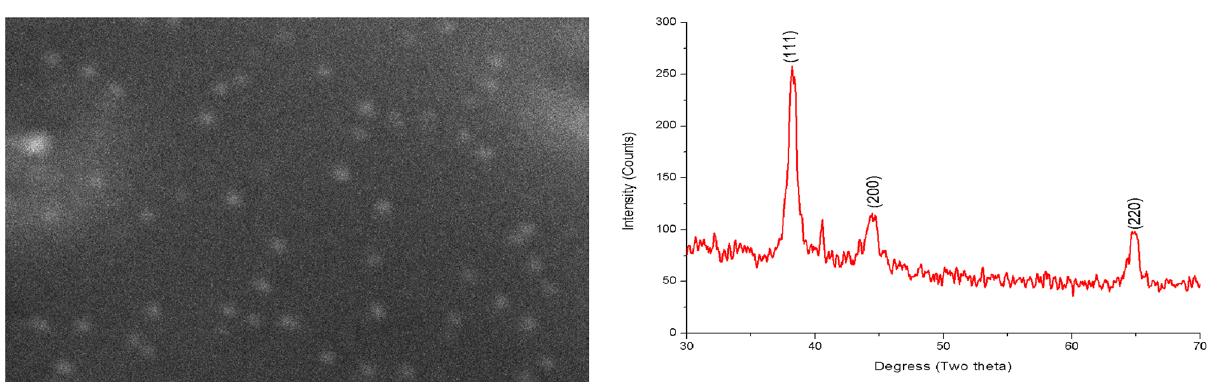
Figure 11: XRD patterns of silver NPs from T. govanianum showing the intense re fl ections with 2 θ